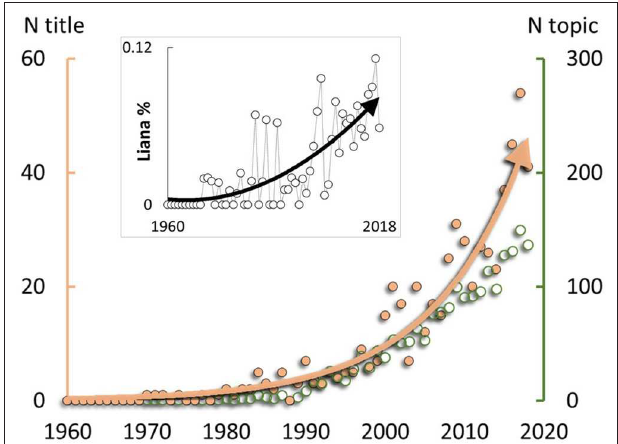
FIGURE 1 | Increasing international research focus on lianas, expanding on previous analysis (Schnitzer et al., 2015). Primary y-axis shows the number of papers per year with primary focus on lianas (i.e., title mentions of “liana” or “lianas”; N title; peach-coloured points; exponential r 2 = 0.93). Secondary y-axis shows the number of papers per year with more general inclusion of lianas (i.e., title, keywords or abstract mentions; N topic; green points; not exponential). Inset: Percentage of 477,915 ecological publications with “liana” or “lianas” mentioned in the title (polynomial r 2 = 0.60). Ecological publications were those categorised as “ecology” by the data source: Thompson Reuters Web of Science Core Collection, 10th April